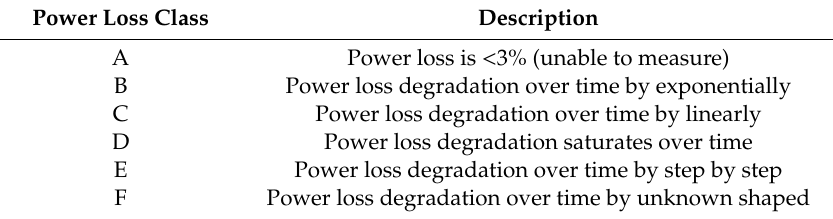
Table 2. Definition of power loss classes.